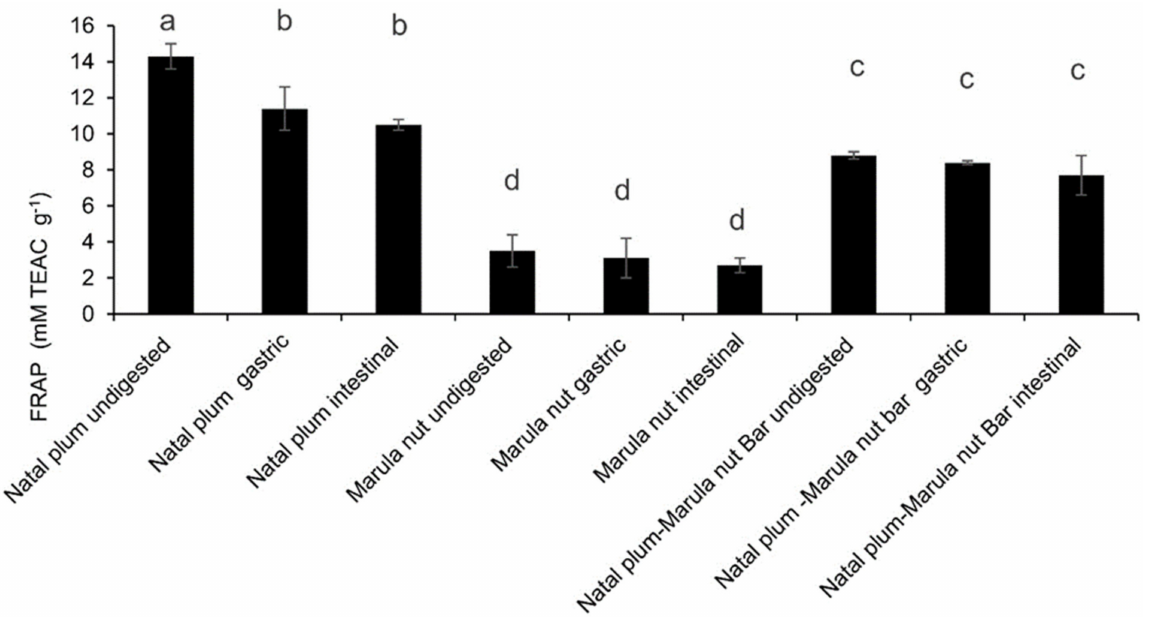
Figure 3. Effect of co-ingestion of Natal plum and Marula nut in a bar on the antioxidant power Means followed by the same letter in a bar are not significantly different at p <